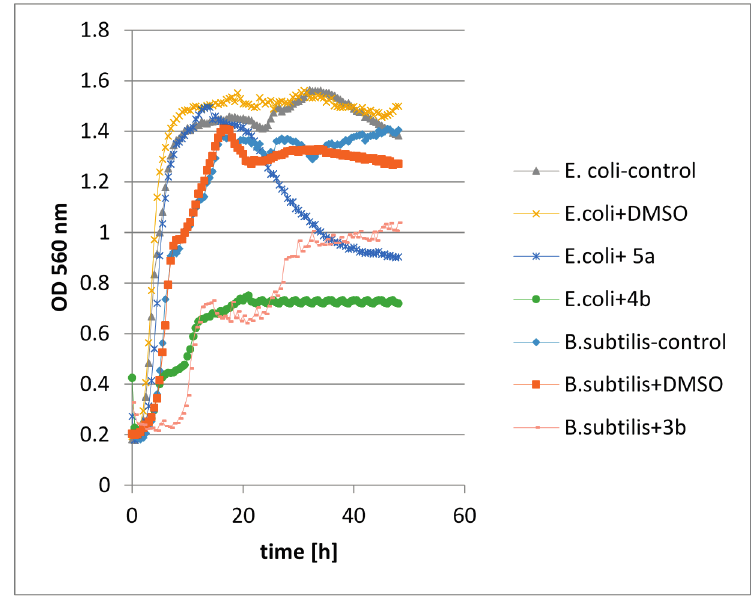
Figure 5. Examples of the effects of selected lactones on the chosen bacteria